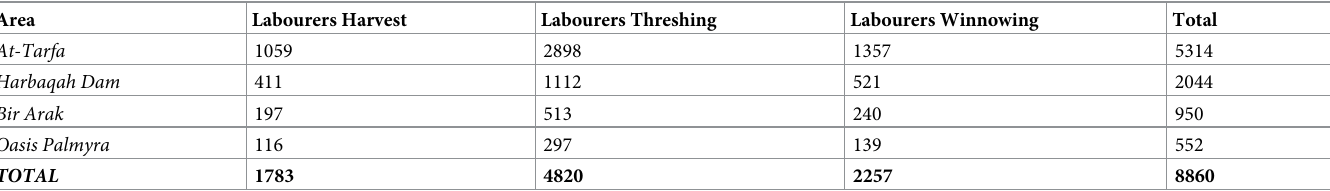
Table 2. Estimated maximum workforce requirements.